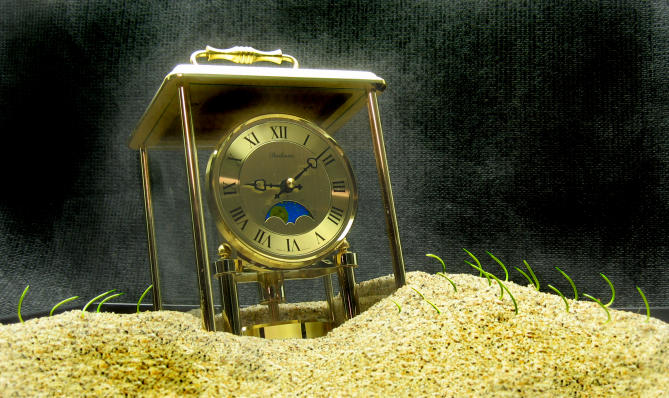
The circadian regulation of auxin responses suggests that many aspects of plant physiology not previously thought to be under circadian control may show time-of-day-specific sensitivity. (Image: Michael F. Covington and Kimberly J. Cope)